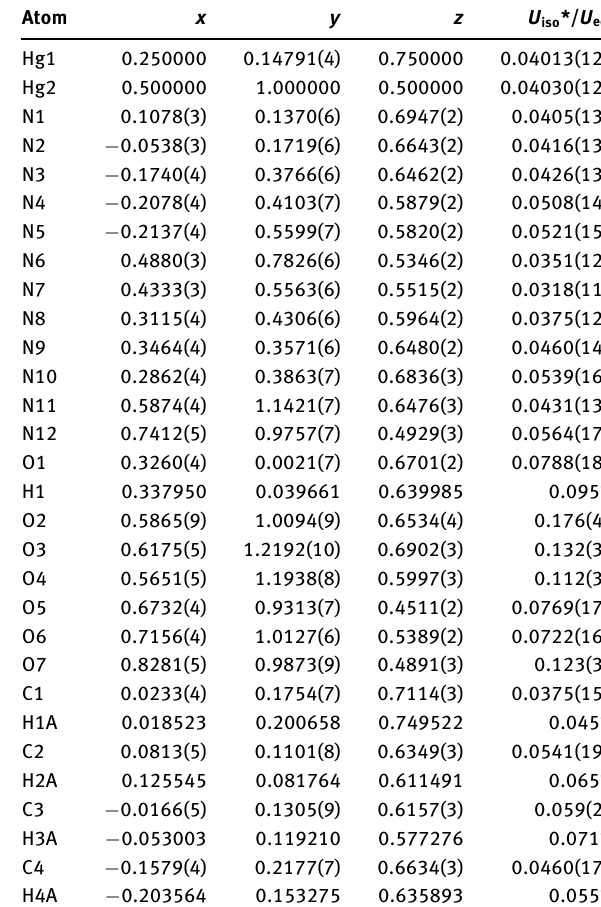
Table 2: Fractional atomic coordinates and isotropic or equivalent isotropic displacement parameters (Å 2